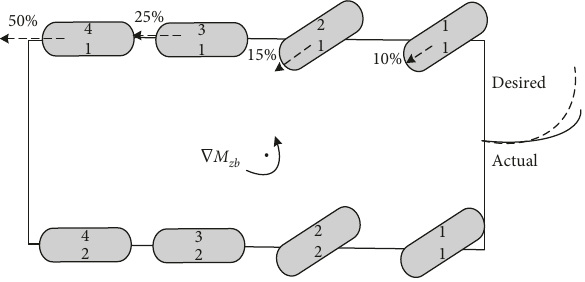
Figure 10: Rule-based braking torque